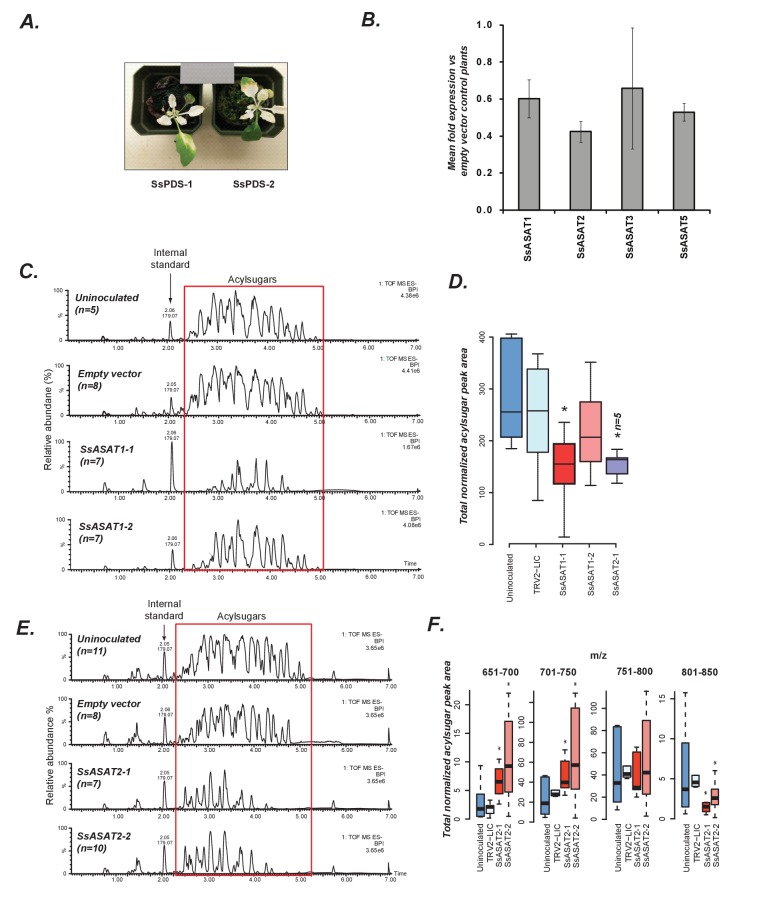
In planta validation of SsASAT1 and SsASAT2 candidates.(A) Two representative plants with the phytoene desaturase gene silenced using VIGS shown with 18% reflectance gray card. SsPDS-1 and SsPDS-2 have two different regions of the SsPDS transcript targeted for silencing. (B) qPCR results of SsASAT VIGS lines. Relative fold change in ASAT transcript abundance in VIGS knockdown plants compared to empty vector plants. Error bars indicate standard error obtained using three technical replicates. Expression level of the phytoene desaturase (PDS) gene was used as the reference control. Figure 3—source data 1 includes values obtained from qPCR analysis. (C,D) SsASAT1 knockdown using two different constructs (SsASAT1-1, SsASAT1-2) shows reduction in acylsugar levels. The SsASAT1-1 phenotype is more prominent than the ASAT1-2 phenotype, being significantly lower (p=0.05; KS test). One construct for SsASAT2 (SsASAT2-1) also showed significant decrease in acylsugar levels (p=0.03; KS test). Note that the Y-axis total ion intensity in (C) is different for each chromatogram. (E,F) SsASAT2 knockdown leads to drops in levels of higher molecular weight acylsugars. In (C–F), number of plants used for statistical analysis is noted. Figure 3—source data 2 describes normalized peak areas from VIGS plants used for making these inferences. Results of the second set of biological replicate experiments performed at a different time under a different set of conditions -- as described in Supplementary file 4 -- is shown in Figure 3—figure supplement 1. Figure 3—figure supplement 2 is a more detailed analysis of the SsASAT2 knockdown phenotype showing the individual acylsugar levels under the experimental conditions.10.7554/eLife.28468.029Figure 3—source data 1.Raw and processed values obtained through qPCR.Data was used to make Figure 3B.10.7554/eLife.28468.030Figure 3—source data 2.Normalized peak areas calculated for VIGS experiments.Individual worksheets describe data obtained from independent experiments. This data was used to make Figures 3D, F, 4B and D.